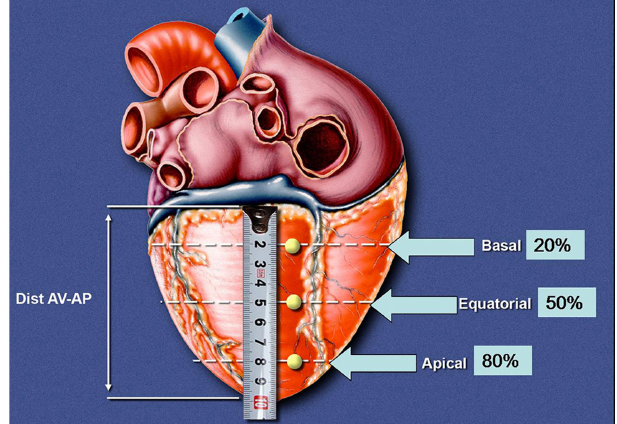
Fig. 1 - Posterior view of a heart with schematic delimitation of dots for ventricular lamination. Basal dot (20%), equatorial dot (50%), apical dot (80%).